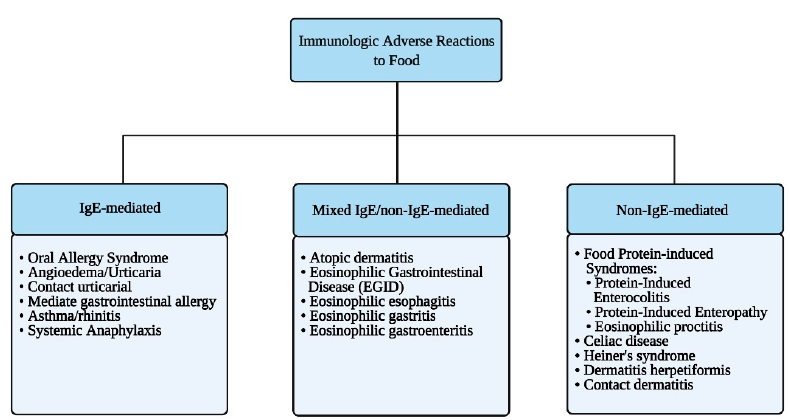
Figure 2. Immunologic adverse reactions to food.